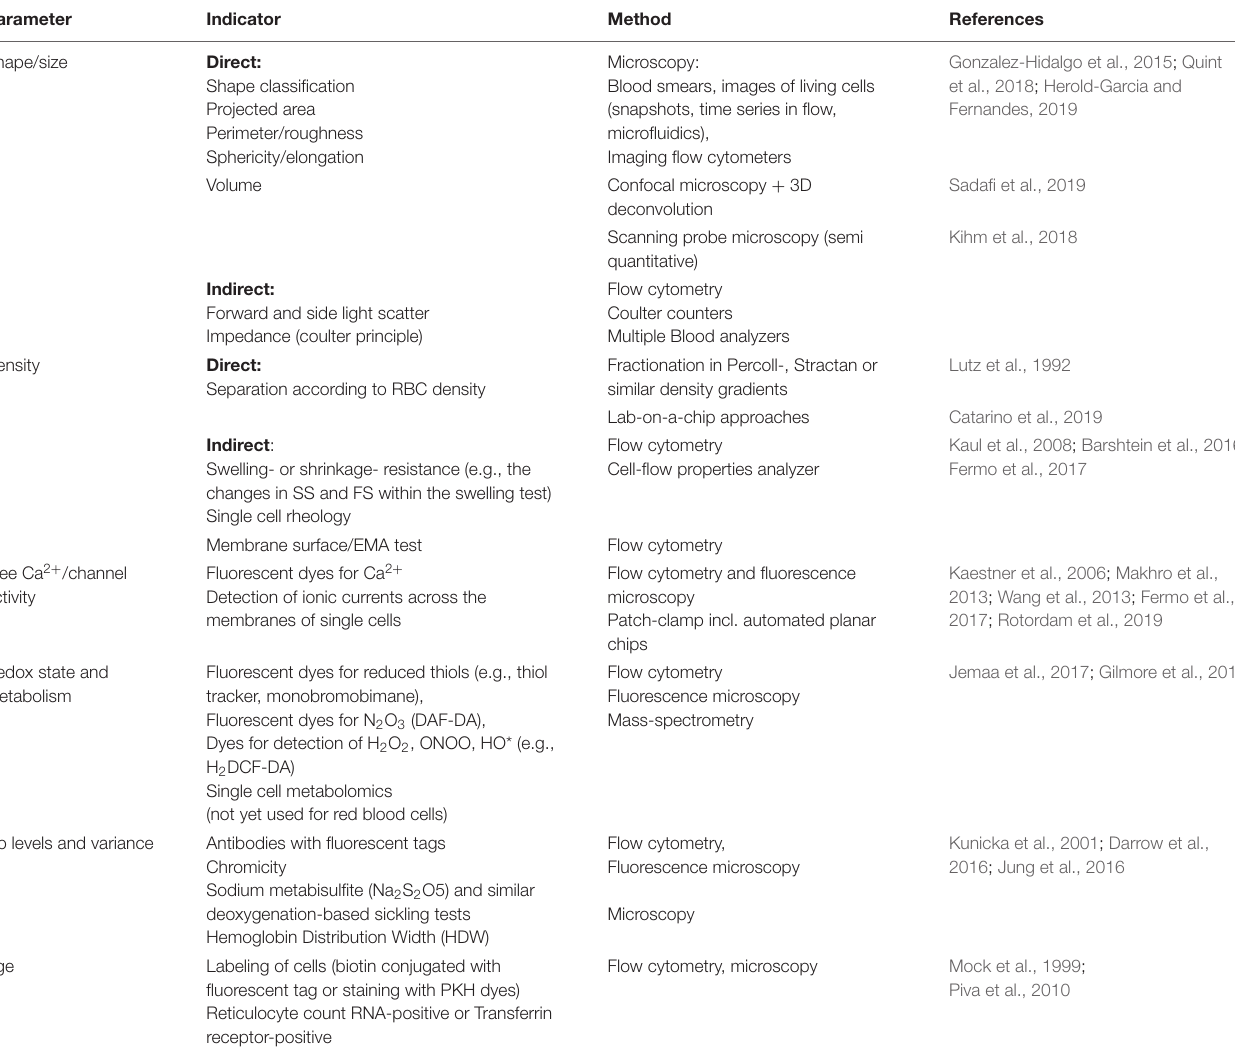
TABLE 1 | Overview of parameters showing inter-cellular heterogeneity as well as basic principle and methodological approaches of their detection in single cells and sub-populations.